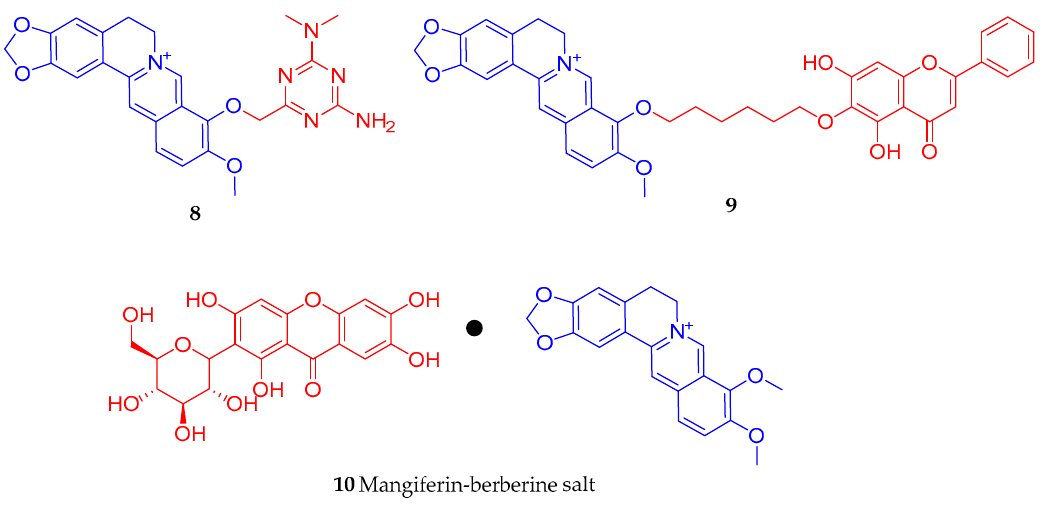
Figure 3. Some examples of berberine conjugates with bioactive compounds.